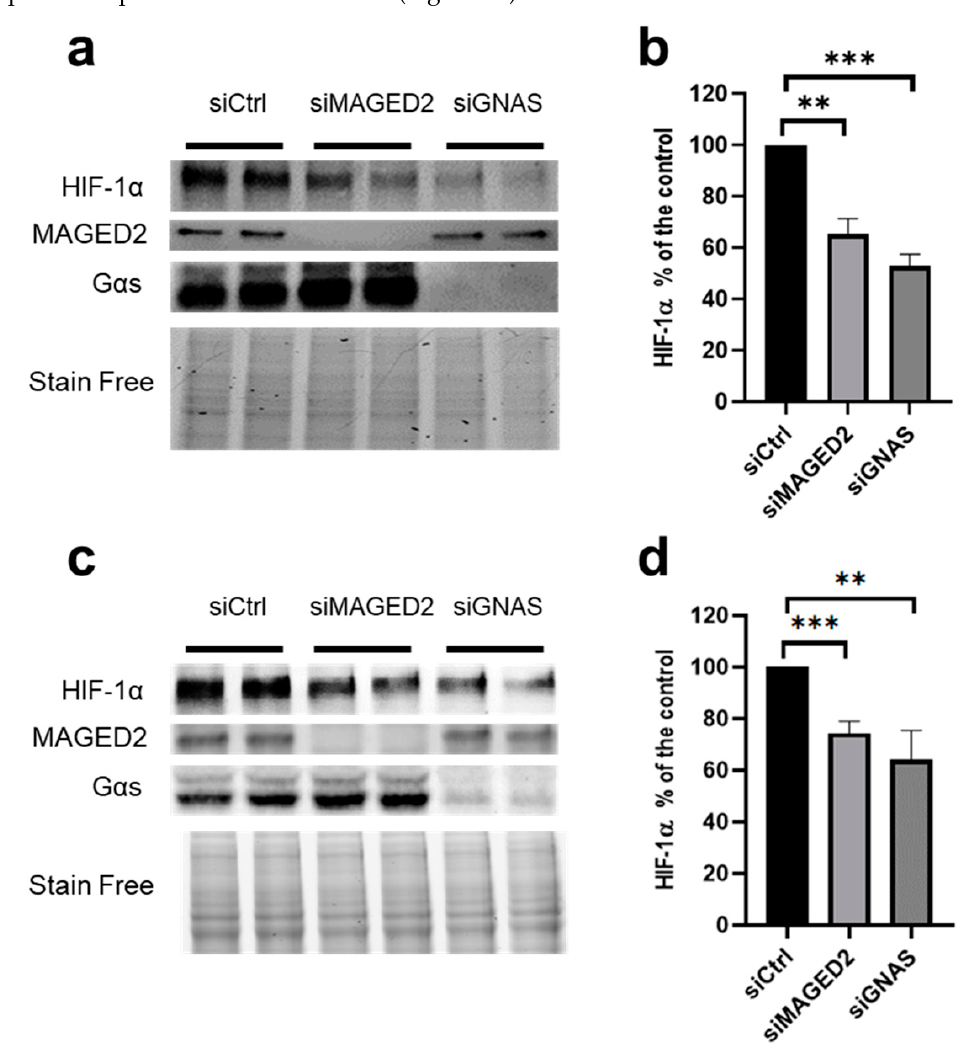
Figure 3. MAGED2 and G α s promote hypoxic HIF-1 α protein expression in HeLa cells. HeLa cells were transfected with control (siCtrl), MAGED2 (siMAGED2) or GNAS (siGNAS) siRNA. Briefly, 24–48 h post-transfection, cells were exposed to physical hypoxia ( a ) or 300 µ M CoCl2 ( c ) for 14–16 h. Total cell lysates were separated by SDS-PAGE and probed with anti-HIF-1 α , MAGED2, and G α s antibodies. ( b , d ) Densitometric analysis of HIF-1 α immunoblot is presented in ( a , c ). Statistical significance was determined by unpaired two-sided Student’s t -test ( b , d ). All Western blots shown are from the same experiment, which is a representative example of three independent